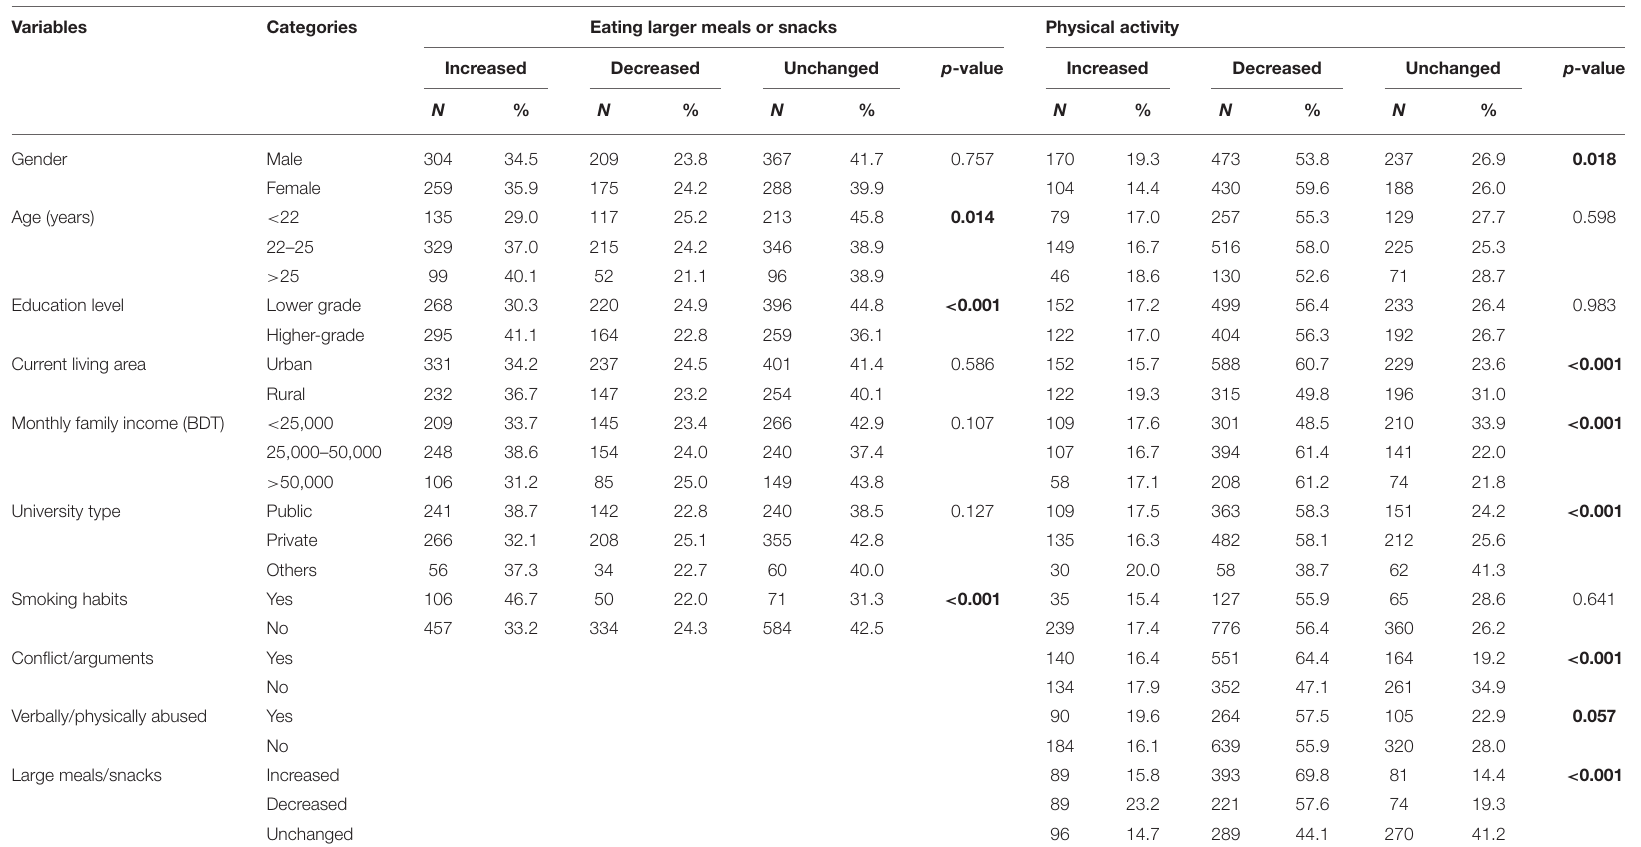
TABLE 3 | Chi-square ( χ 2 ) test for finding the potential association of sociodemographic factors impacting eating larger meals/snacks and physical activity among university students following prolonged lockdown in Bangladesh ( N =